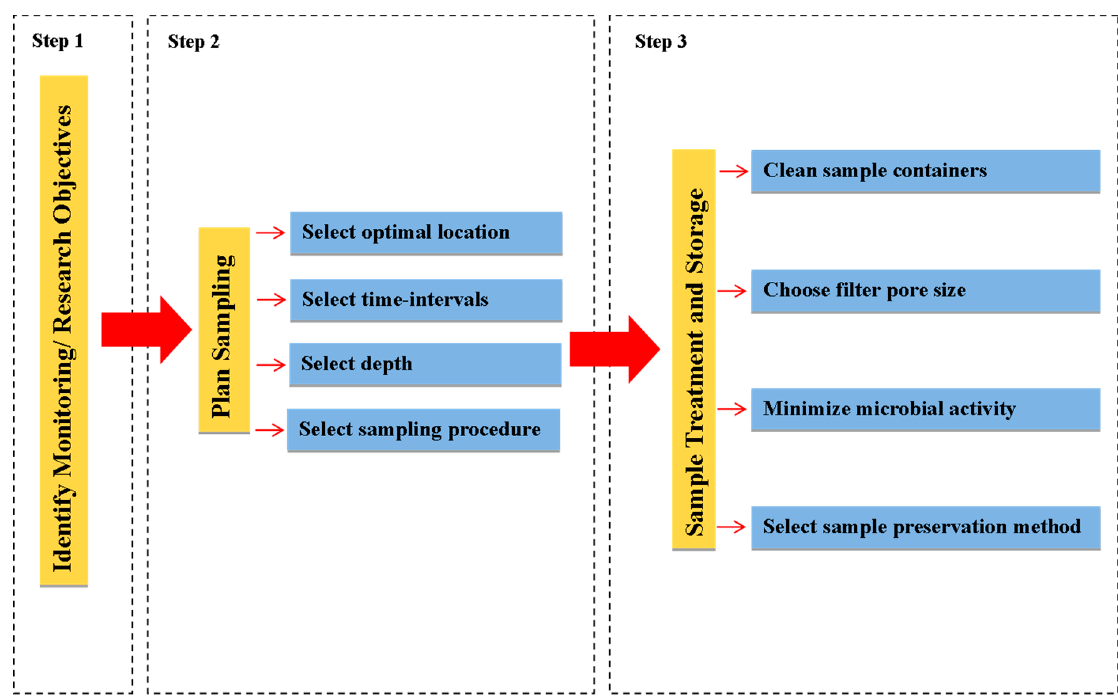
Figure 1. Diagram of comprehensive freshwater monitoring steps for P .